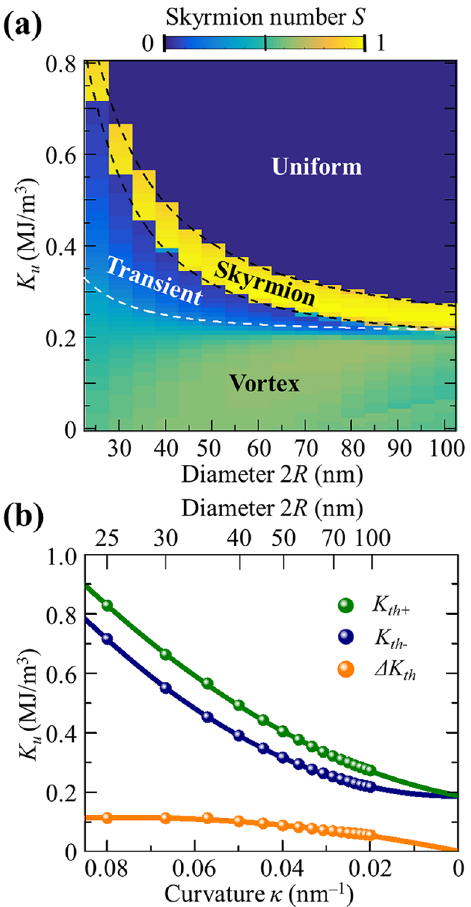
Figure 3. Phase diagram of spin textures. ( a ) Phase diagram with topological charge of meta-stable state as function of shell diameter 2 R and anisotropy K u . The possible meta-stable states are (1) skyrmion, (2) uniform, and (3) vortex. The black dotted lines represent the upper and lower limits within which skyrmions are well formed, and the white dotted line represents the boundary between the vortex and transient states. ( b ) Upper- and lower-limit K th values as function of curvature. The solid lines represent the fittings to the